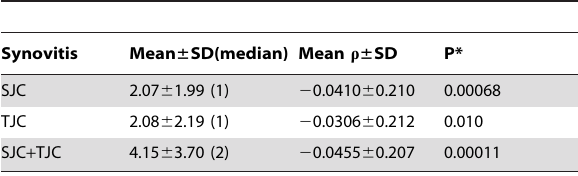
Table 2. Mean correlation coefficients between joint synovitis and air pressure in the 326